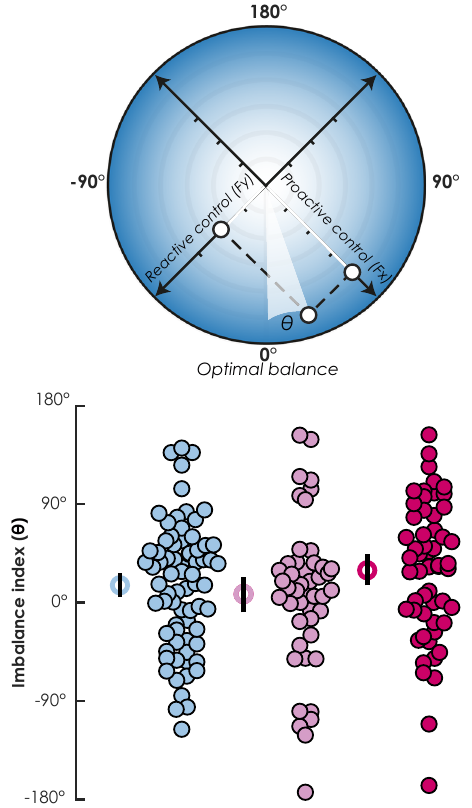
Fig. 6 Geometric interpretation of predictive and reactive control as perpendicular forces. Left panel: circular projection of the resultant vector of predictive (i.e., belief) and reactive (i.e., PE + ) control forces. 0° represents the optimum balance between these two orthogonal forces. The angle of the resultant force indicates imbalance toward either predictive ( θ > 0 (cid:3) ) or reactive ( θ < 0 (cid:3) ) control. The right panel shows the distribution of this imbalance index for each of the three groups. The empty circles represent the group circular average ± bootstrapped 95% CI for nonexposed ( n sample size = 72), PTSD − ( n sample size = 46) and PTSD + ( n sample size =